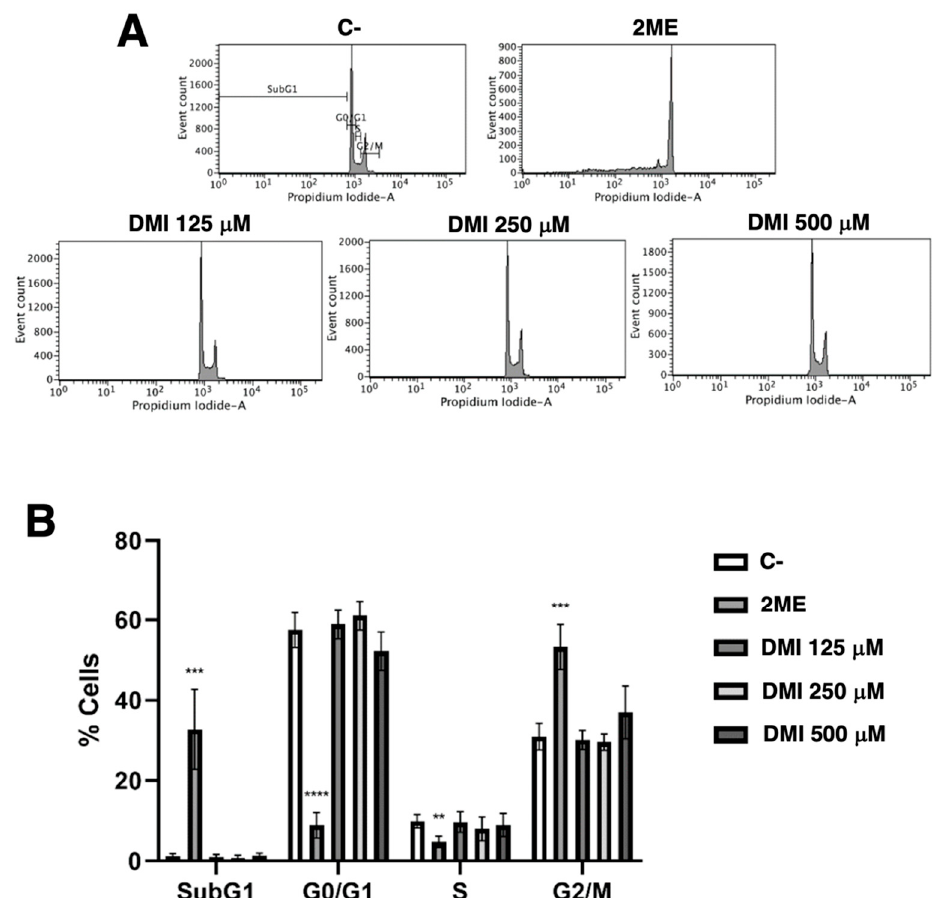
Figure 4. Effect of DMI on endothelial cell cycle. ( A ) BAECs were exposed for 16 h to DMI at the indicated concentrations to DMSO (negative control, at non-toxic concentrations, well below 1% v / v ) or to 10 µM 2-ME (positive control) [9], stained with propidium iodide and the percentages of cells on subG1, G1, S, and G2/M phases were determined using a FACS VERSETM cytometer. ( B ) Quantification of the percentages of cells at each stage of the cell cycle. Data are represented as means ± S.D. for four independent experiments. ** p < 0.01, *** p < 0.001, **** p < 0.0001 versus negative control.